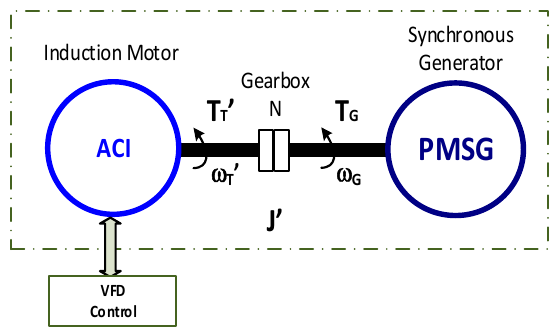
Figure 11. Mechanical model of the proposed wind turbine emulator.